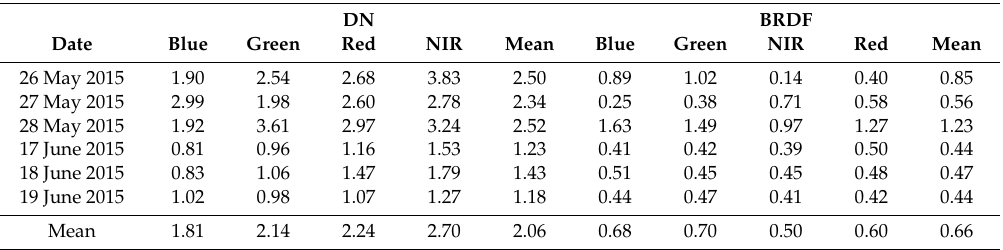
Table 10. Uncertainty of tarp DN in satellite images and the bidirectional reflectance distribution function (BRDF) (unit: %).